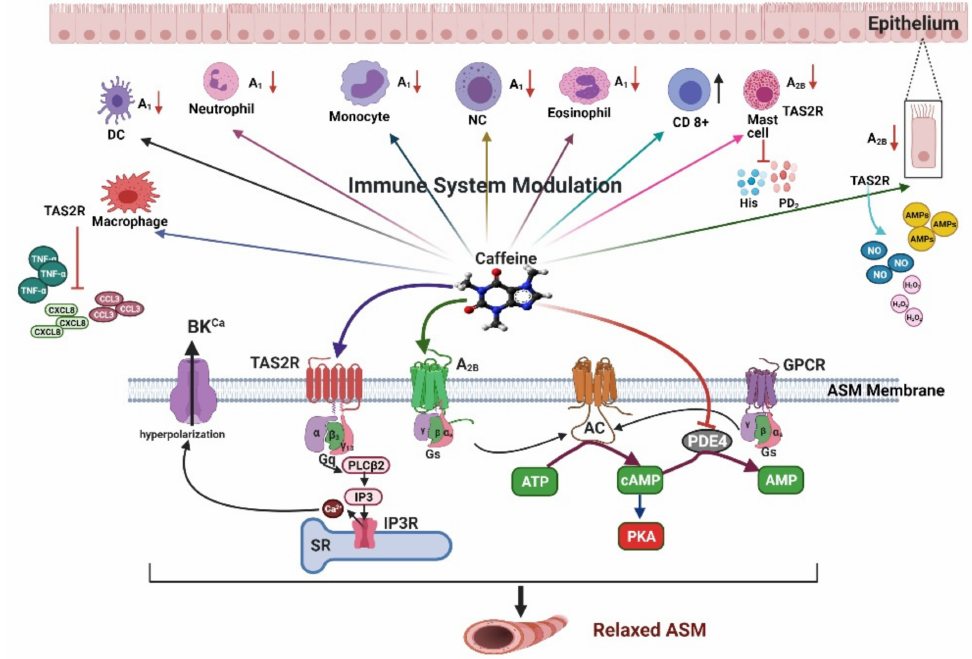
Figure 1. Schematic diagram of the immunomodulatory and bronchodilatory effects of caffeine. Various cells of the immune system express adenosine receptors (ARs) and TAS2R receptors that can modulate their activity; caffeine is a known antagonist of the AR receptor and an agonist of TAS2R receptors. Antagonism of A 1 and A 2B on immune cells will decrease pro-inflammatory activity. Caffeine activation of TAS2R in epithelial cells will increase the secretion of antimicrobial peptides (AMPs), NO, and H 2 O 2 , all of which have direct effects on the virus. In macrophages it inhibits pro-inflammatory cytokine production, and in mast cells it inhibits histamine and prostaglandin D 2 release. In ASM, caffeine can activate various pathways that promote bronchodilation: it activates TAS2R and A 2 receptors and inhibits PDE4 to induce relaxation. At high concentrations, it can also increase the open probability of RyR; this last mechanism has no therapeutic use. ASM, airway smooth muscle; AR, adenosine receptor; DC, dendritic cell; GPCRs, G-protein-coupled receptors; TAS2R, type 2 taste receptor; NC, natural killer cell; CD, lymphocyte CD 8+; His, histamine; PD2, prostaglandin D2; PDE4: phosphodiesterase 4; AMPs, antimicrobial peptides; IP 3 , inositol 1,4,5- triphosphate; PLC- β 2 , phospholipase C- β 2 ; SR, sarcoplasmic reticulum; PKA, protein kinase A; cAMP, cyclic adenosine monophosphate; GPCR, G-protein-coupled receptor; IP3R, IP 3